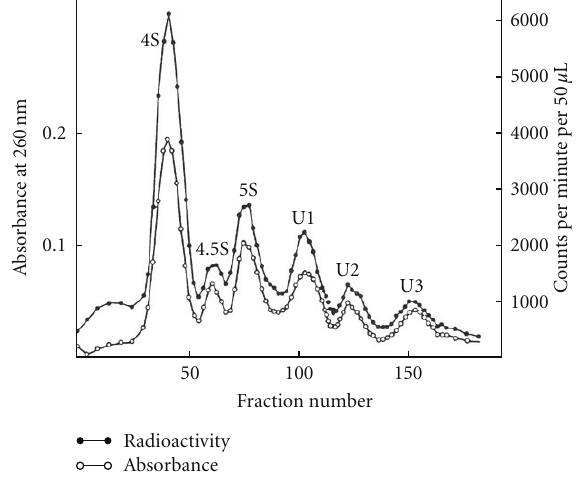
Figure 13: Preparative gel electrophoretic pattern of 4–7S RNA labeled with [ 3 H] [16]. The intact, labeled RNA (as in Figure 12) was subjected to preparative polyacrylamide gel electrophoresis. The UV absorption and radioactivity were measured.